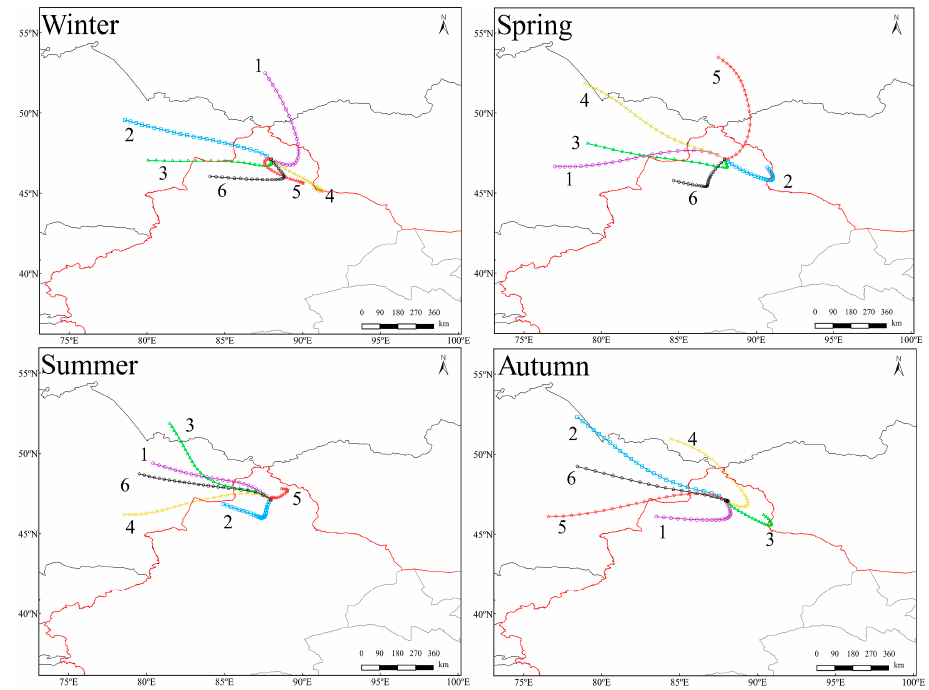
Figure 4. Cluster-mean back-trajectories by using the hybrid single-particle Lagrangian integrated trajectory (HYSPLIT) model in Akedala Station from January 2017 to December 2019.